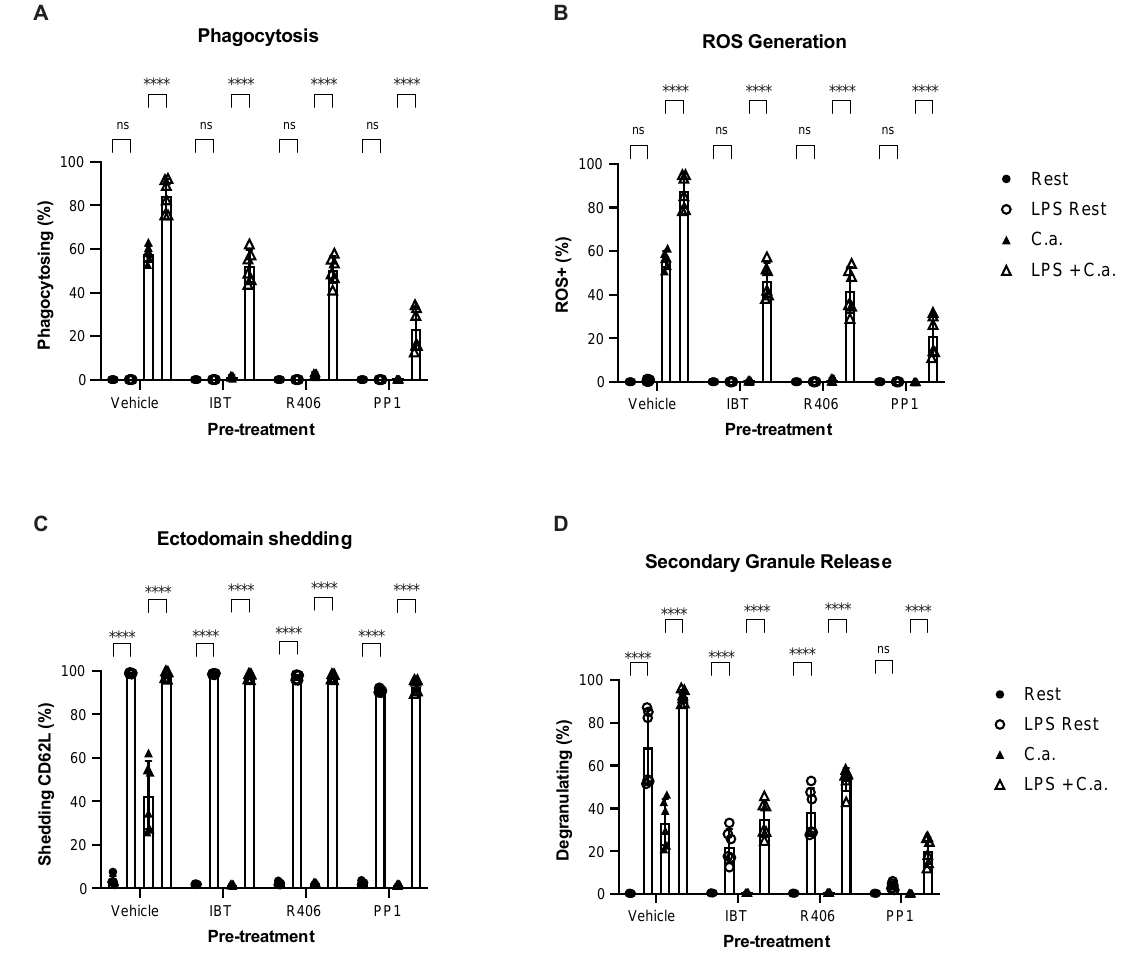
Figure 7. Multiparametric assay provides a simple format for measuring recovery of function in chemically inhibited neutrophils. Neutrophils were pre-treated with kinase inhibitors ibrutinib (IBT), R406, PP1 or DMSO vehicle control (Vehicle) for 30 min in the reaction well. Lipopolysaccharide (LPS, LPS + C.a.) or the LPS vehicle (Rest, C.a.) was then spiked into the reaction well and neutrophils incubated for an additional 45 min. Finally, neutrophils were co-cultured with C. albicans (MOI of 4) for 30 min (C.a., LPS + C.a.). The frequency of total neutrophils performing phagocytosis ( A ), ROS generation ( B ), ectodomain shedding ( C ), or secondary degranulation ( D ) was measured at rest (Rest) and after co-culture (C.a.). Data are represented as mean ± SD; n = 3 per group in each experiment per donor; experiments were repeated two times with two different donors. Data were analyzed by one-way ANOVA with a Tukey posttest. **** p < 0.0001.